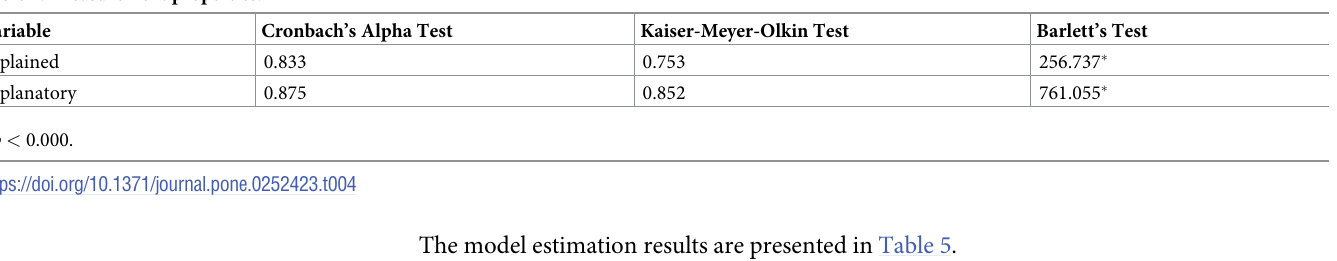
Table 4. Measurement properties.